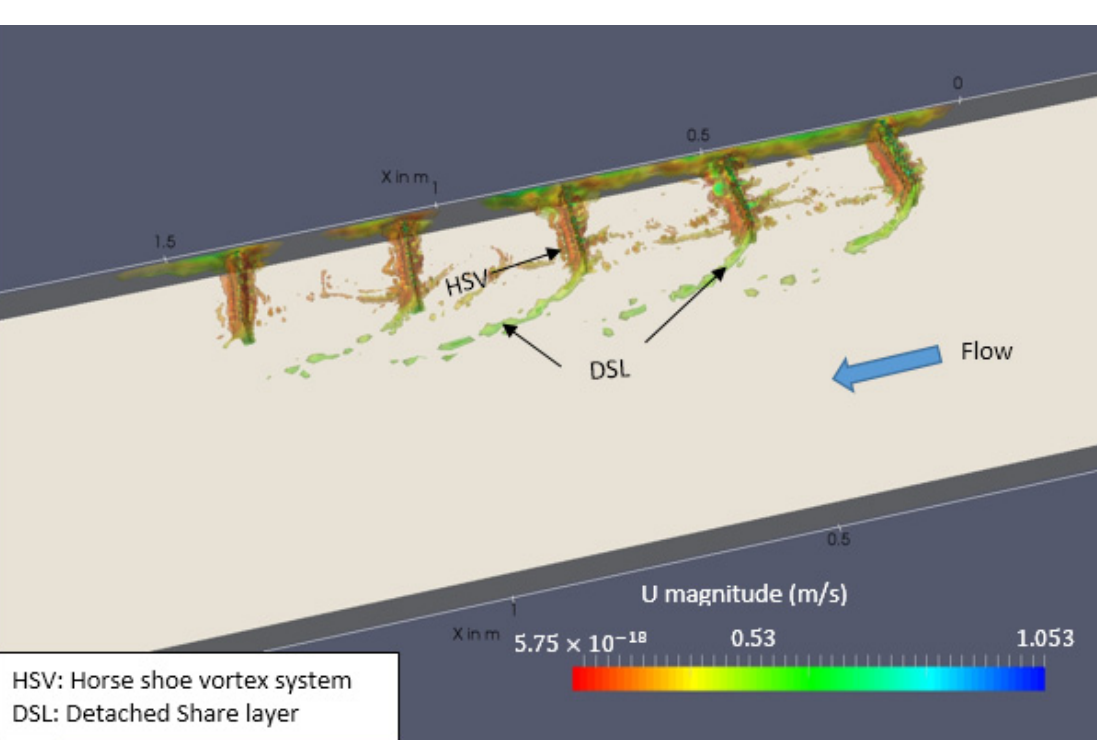
(cid:3049) , (cid:3050) ) 0.02 m upstream of the third spur dike. The (cid:3022) (cid:3022) (cid:3049) ) . (cid:3022)